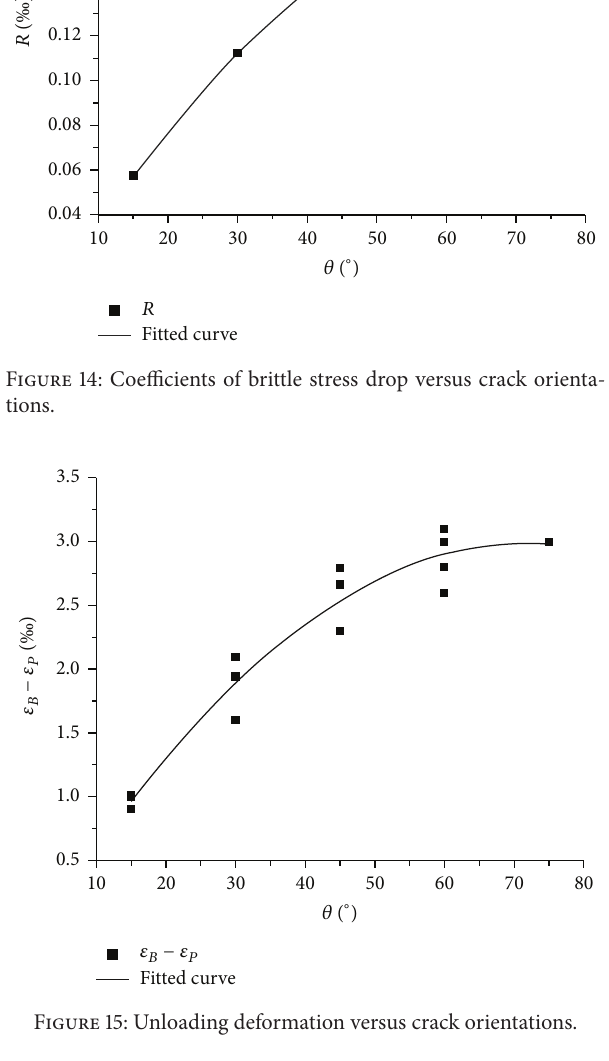
Figure 13: Axial strain at the elastic stage which corresponds to the residual strength versus crack orientations.